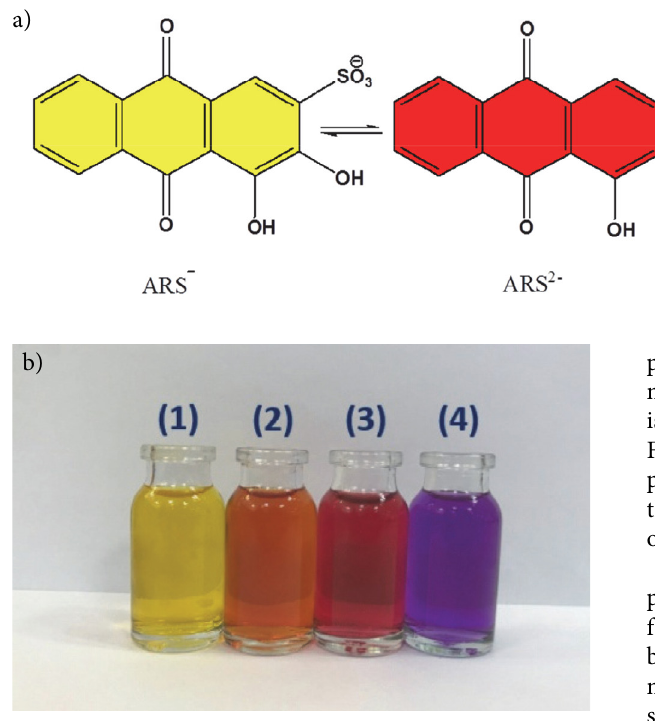
Figure 6. (a) Equilibrium relations among different types of ARS molecules at various pHs and (b) various forms of ARS molecules